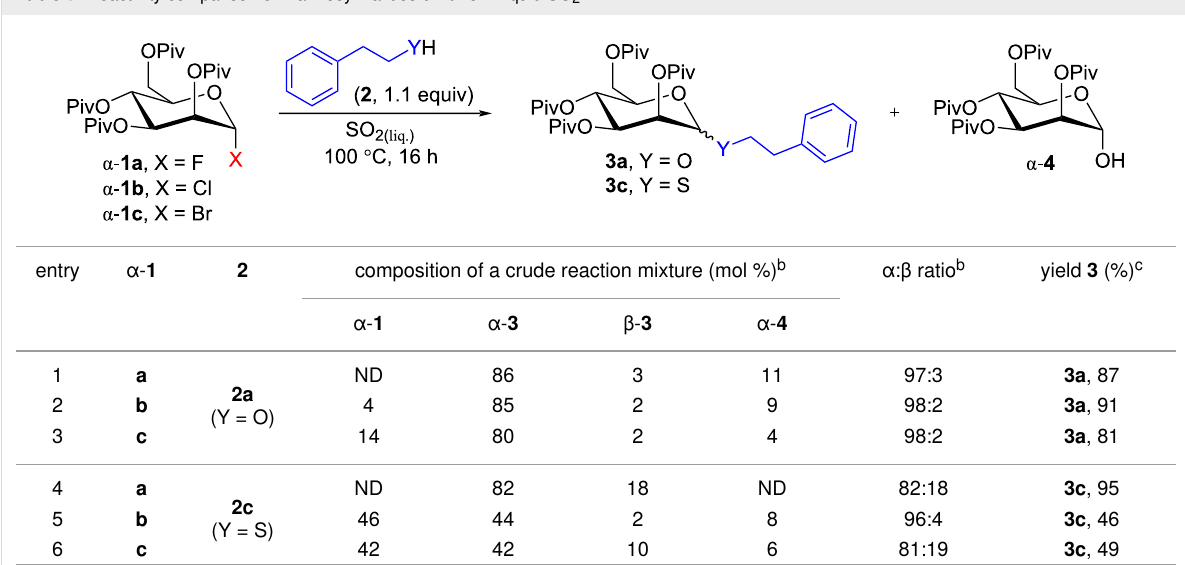
Table 3: Reactivity comparison of mannosyl halides α - 1a–c in liquid SO 2 . a